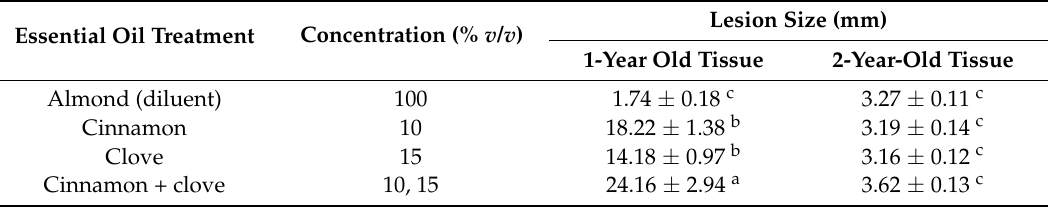
Table 2. Phytotoxicity of essential oils in one- and two-year-old P. radiata tissue. Cinnamon and clove oils were diluted to the indicated concentration in sweet almond oil. Values shown are the means of 12 lesions ± standard error. Statistically significant ( p < 0.05) differences in lesion sizes among the treatments are indicated with a different lowercase letter.